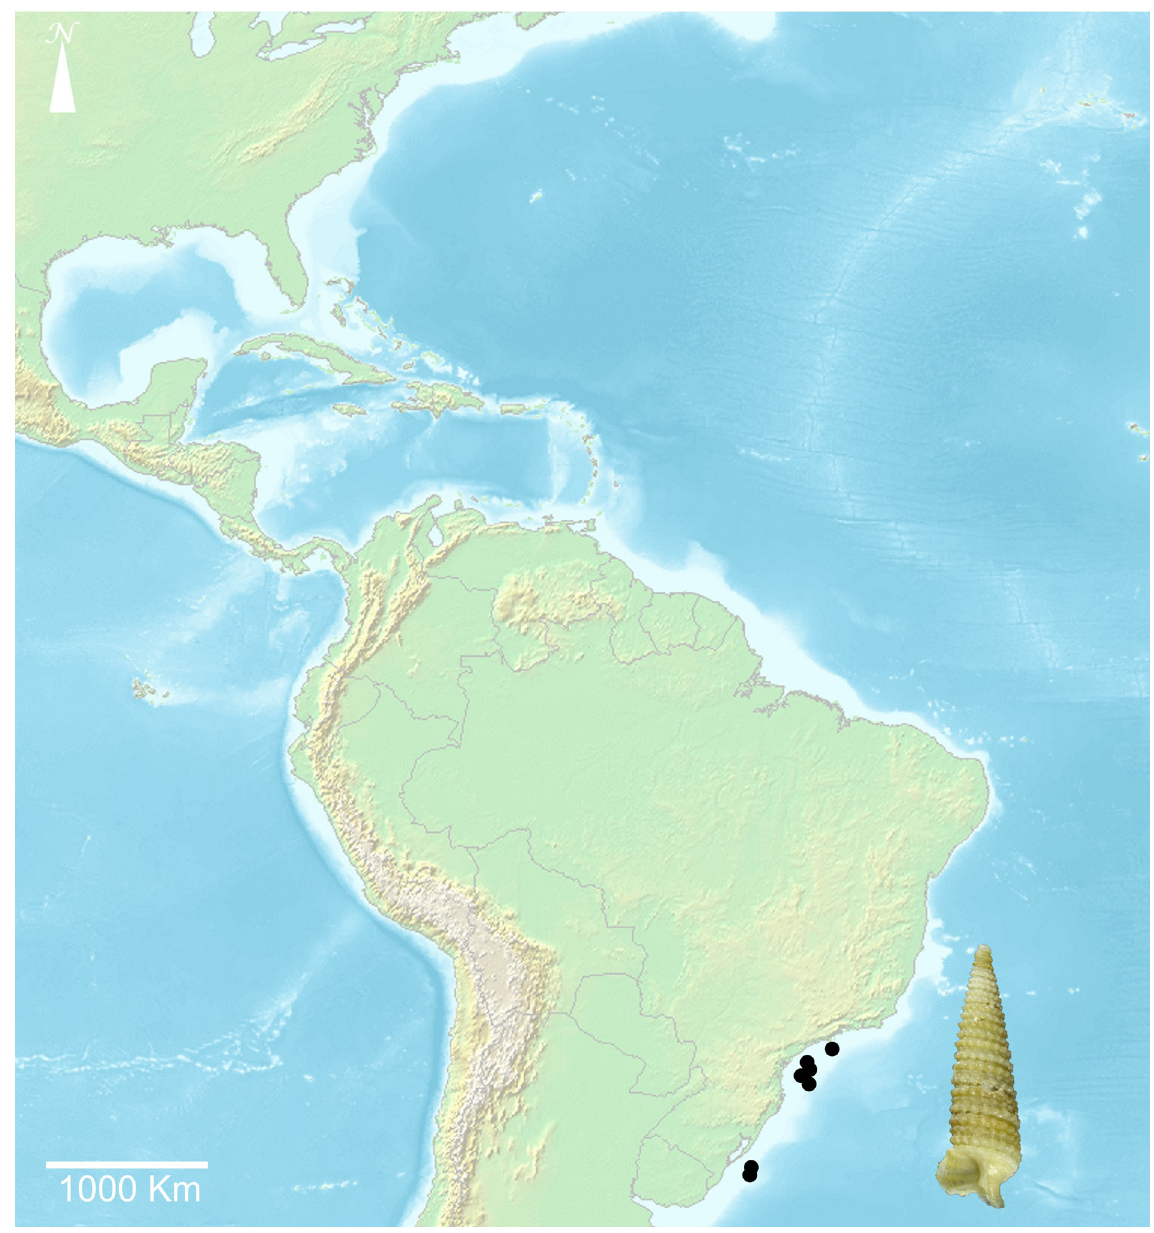
Fig. 46. Distribution map of “ Inella ” sp.